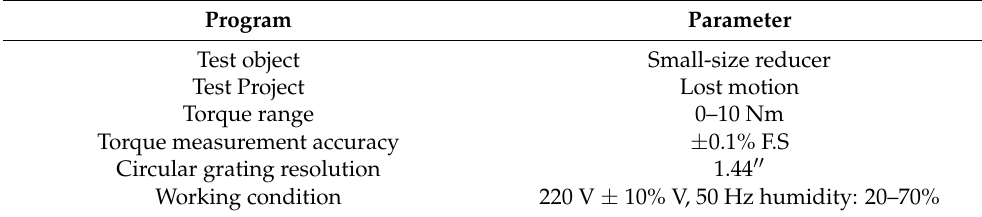
Figure 12. Testing machine. Table 2. Main technical indexes of testing